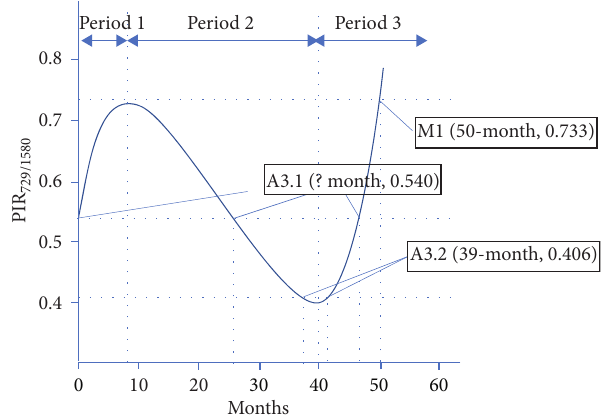
Figure 6: Estimation of ink dating by the time dependency model of CV with modified period